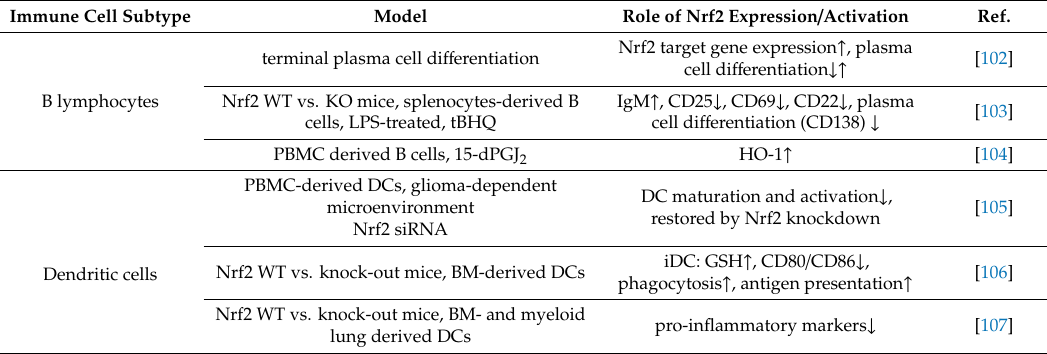
Table 1. Role of Nrf2 in the function of immune cell subpopulations. To characterize a putative role of Nrf2 in the treatment of sepsis patients, it is important to know how the activation of Nrf2 and its downstream signaling a ff ect cell subpopulations of the immune response. In immune cells of the innate and adaptive immune systems, Nrf2 has been shown to be important for di ff erentiation and function. Thus, B lymphocytes, dendritic cells, granulocytes, monocytes / macrophages, natural killer cells, and T lymphocytes express Nrf2 and are regulated by its signaling. ↑ upregulated, ↓ downregulated, ↓↑ not altered; RTA-402 (CDDO-Me, BARD-Me, bardoxolone methyl); RT-408 (omaveloxolone); SFN, sulforaphane; DMF, dimethyl fumarate; DEM, diethylmaleate; 15d-PGJ 2 , 15-deoxy- ∆ 12,14 -prostaglandin J 2 ; tBHQ, tert-butylhydroquinone; TMZ, tert-butylhydroquinone; NaB, sodium butyrate; ab, antibody; AKI, acute kidney injury; COPD, chronic obstructive pulmonary disease; IR, ischemia-reperfusion. Immune Cell Subtype